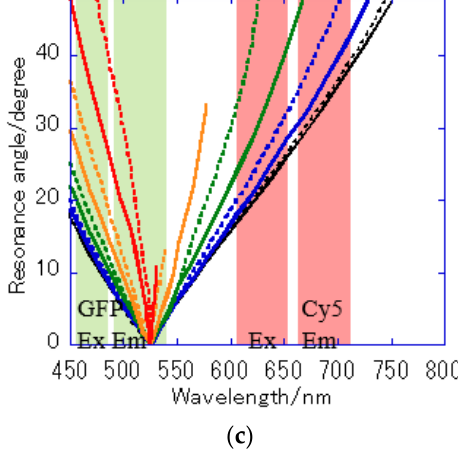
Figure 8. Resonance angle spectra calculated from the theoretical resonance condition at the water interface every 10° of the azimuth angle φ : ( a ) 𝑘 𝑔𝑥(1) of Bull’s eye type with 400 nm pitch; ( b ) 𝑘 𝑔𝑥(1) of hole-arrayed type with 500 nm pitch; and ( c ) 𝑘 𝑔𝑥45(2) of hole-arrayed type with 500 nm pitch. φ = 0 (black solid line), 10 (black broken line), 20 (blue solid line), 30 (blue broken line), 40 (green solid line), 50 (green broken line), 60 (orange solid line), 70 (orange broken line), 80 (red solid line), and 90 (red broken line). The green and red bands correspond to the excitation wavelength range and the emission range of the GFP and Cy5 filters, respectively.